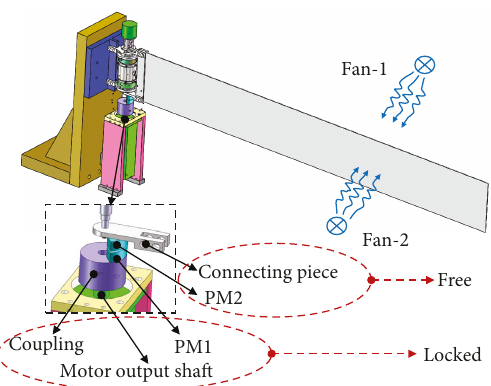
Figure 13: Experiment test setup diagram with the periodic fan airflow stimulation and passive damping.